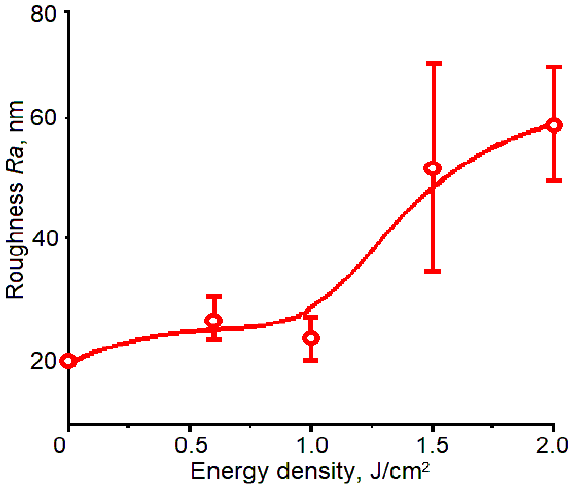
Figure 2. The SEM-images of the 321 steel surfaces: as-received ( a ), as well as after HIPIB irradiation at the energy densities of ( b ) 0.6, ( c ) 1.0, and ( d ) 2.0 J/cm 2. .